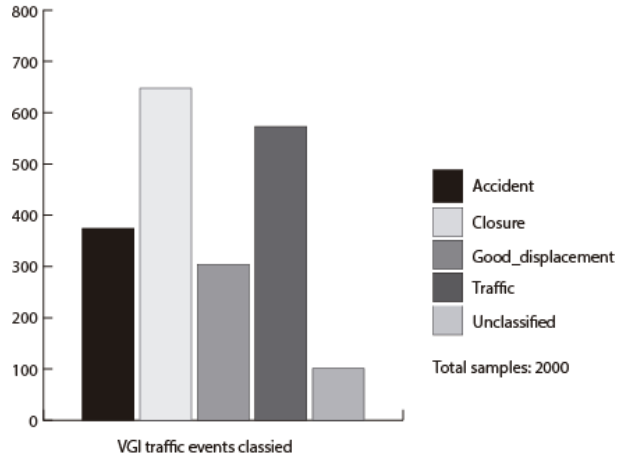
Figure 6. Percentages of samples for each proposed traffic class obtained after the KNN classification